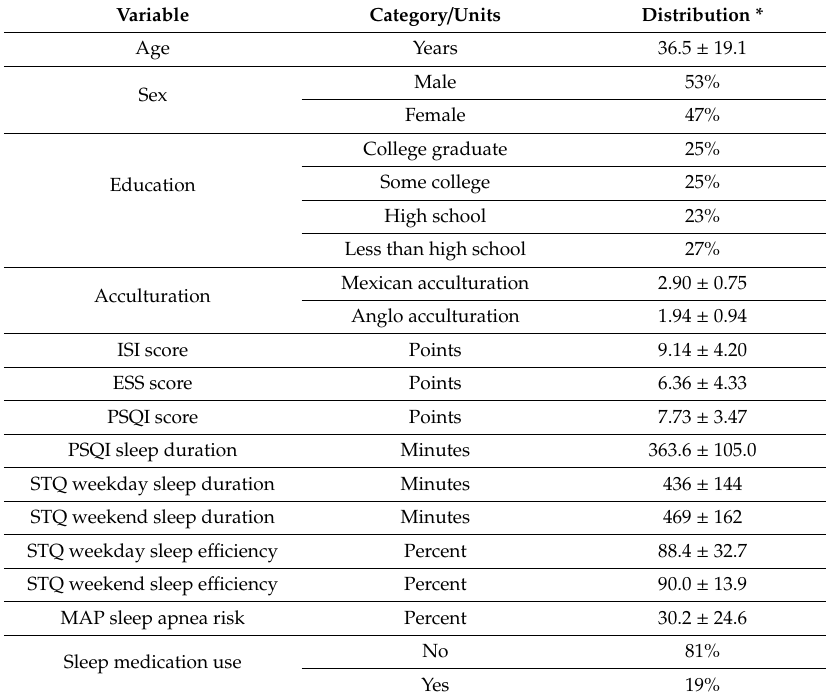
Table 1. Characteristics of the